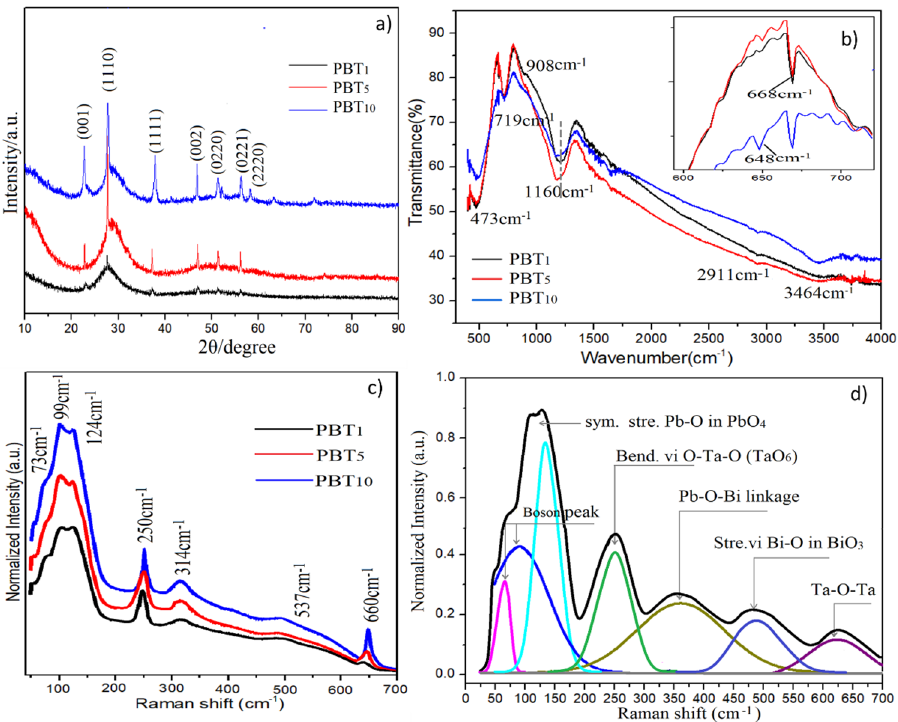
Figure 4. XRD pattern ( a ), FT-IR spectra ( b ), Raman ( c ), and Raman deconvolution (of PBT 10 ) ( d ) of three samples.